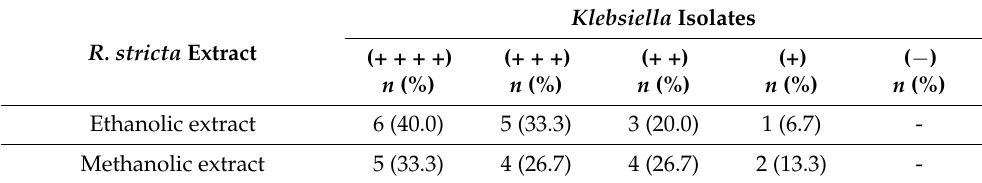
Table 6. Antimicrobial activity of Rhazya stricta leaves extract against Klebsiella isolates.